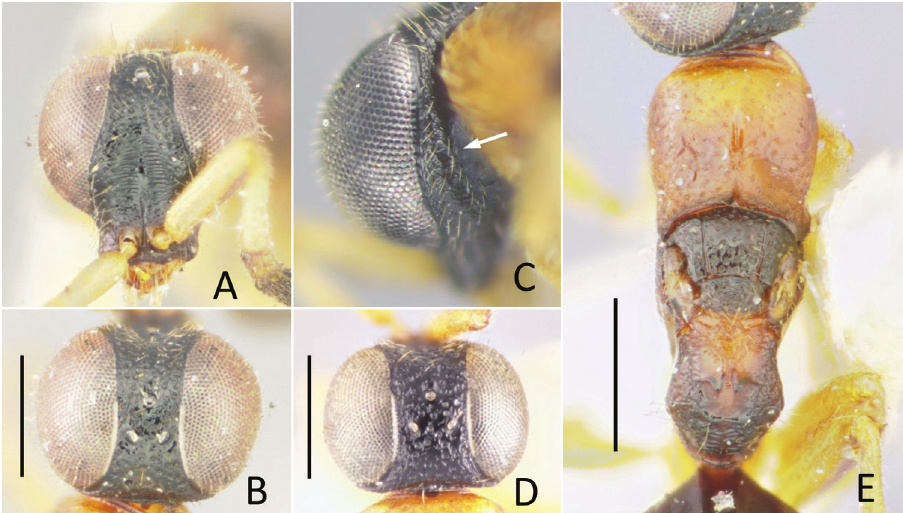
Figure 8. Nipponosega yamanei Kurzenko & Lelej ♀ A holotype of N. yamanei , head in frontal view B ditto, dorsal view C female from Aichi, gena (arrow indicates occipital carina) D holotype of N. kan- toensis Nagase, head in dorsal view E holotype of N. yamanei , mesosoma. Scale bars: 0.5